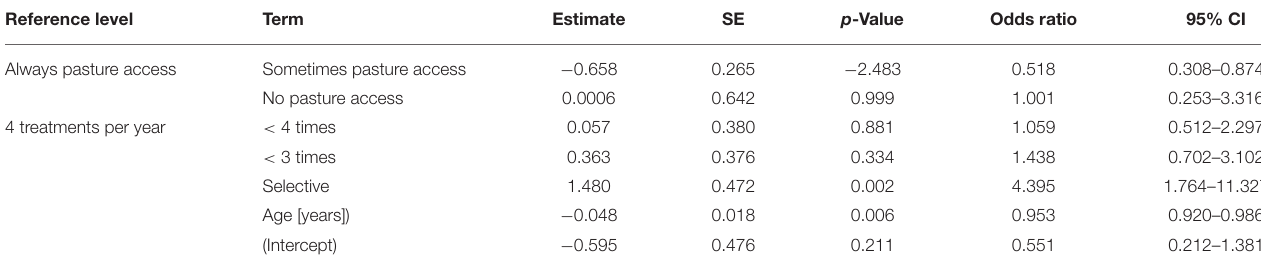
TABLE 6 | Final logistic regression model to identify risk factors to be positive for antibodies against the Strongylus vulgaris recombinant SvSXP larval antigen. Reference level